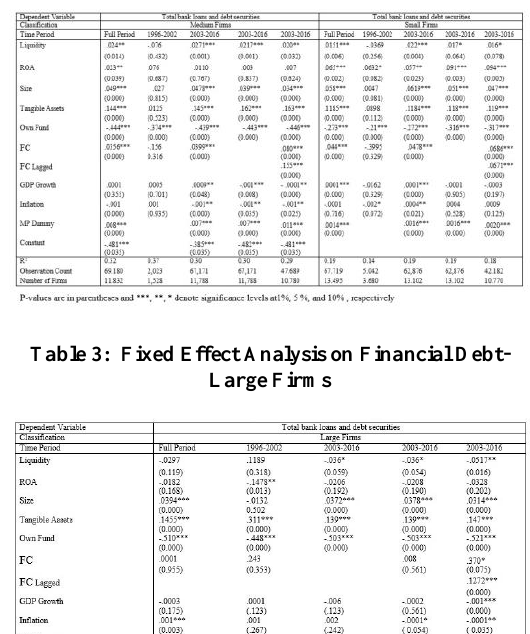
Table 2: Fixed Effect Analysis on Financial Debt -